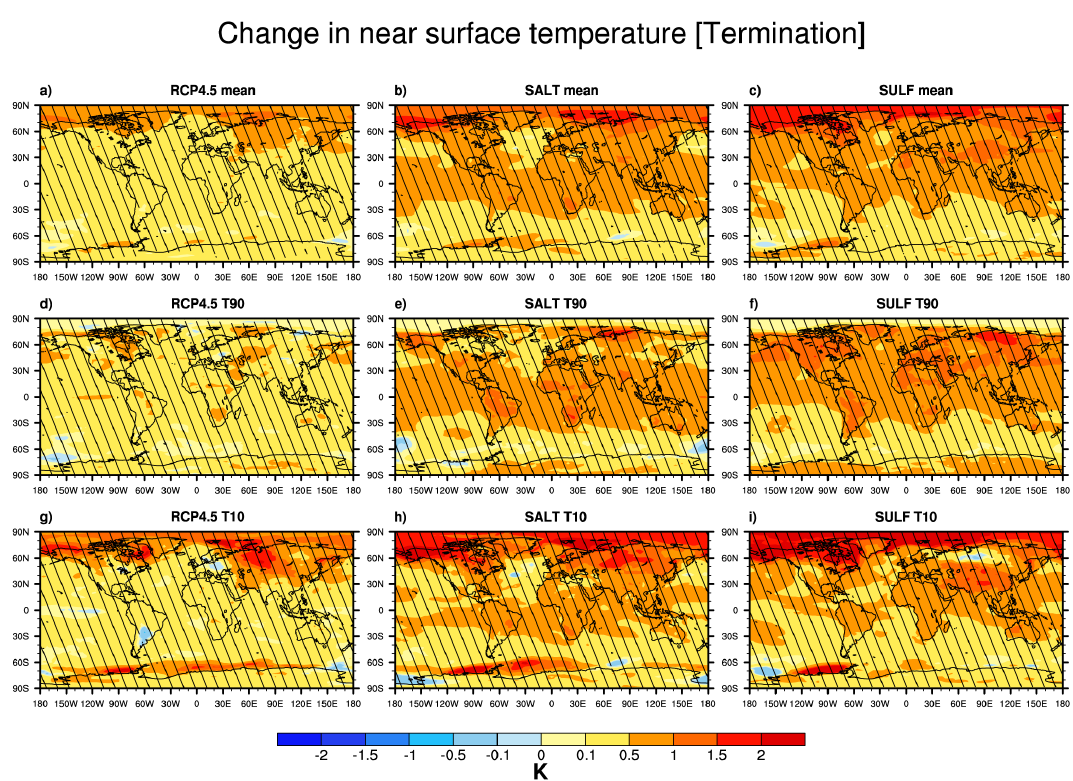
Figure 9. Multi-model mean change in temperature (K) during climate engineering termination period for RCP4.5 (left panel), SALT (mid- dle) and SULF (right panel). Panels (a) to (c) denote changes in mean values, (d) to (f) same as (a) to (c) but for the 90th percentile and (g) to (i) same as (a) to (c) but for the 10th percentile of the temporal distribution at each model grid point. Hatches denote regions where the changes are 95% statistically significant.